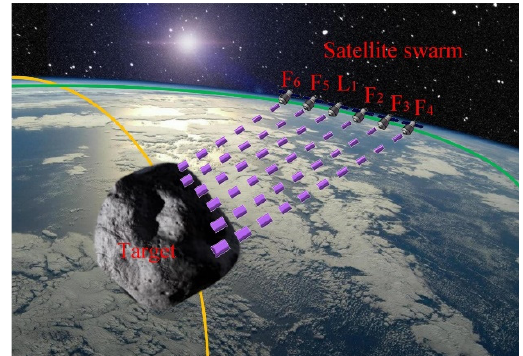
Figure 1. Scenario for the tracking and observing swarm.